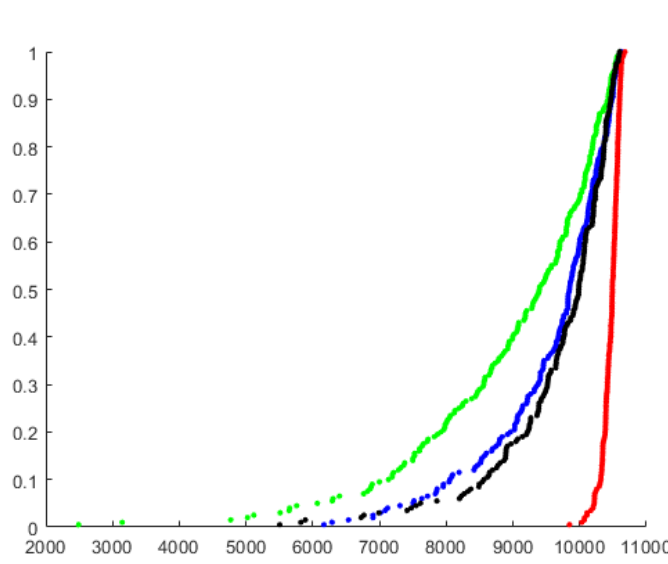
Figure 15. CDF of cumulative rewards ( λ a = 42,000). FIFO; , EDF; , Greedy; , RPS.